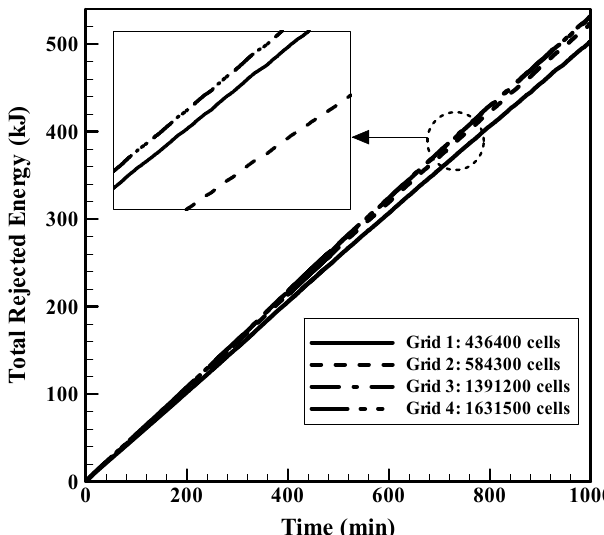
Figure 6. Effect of different grids on the total rejected energy (kJ).